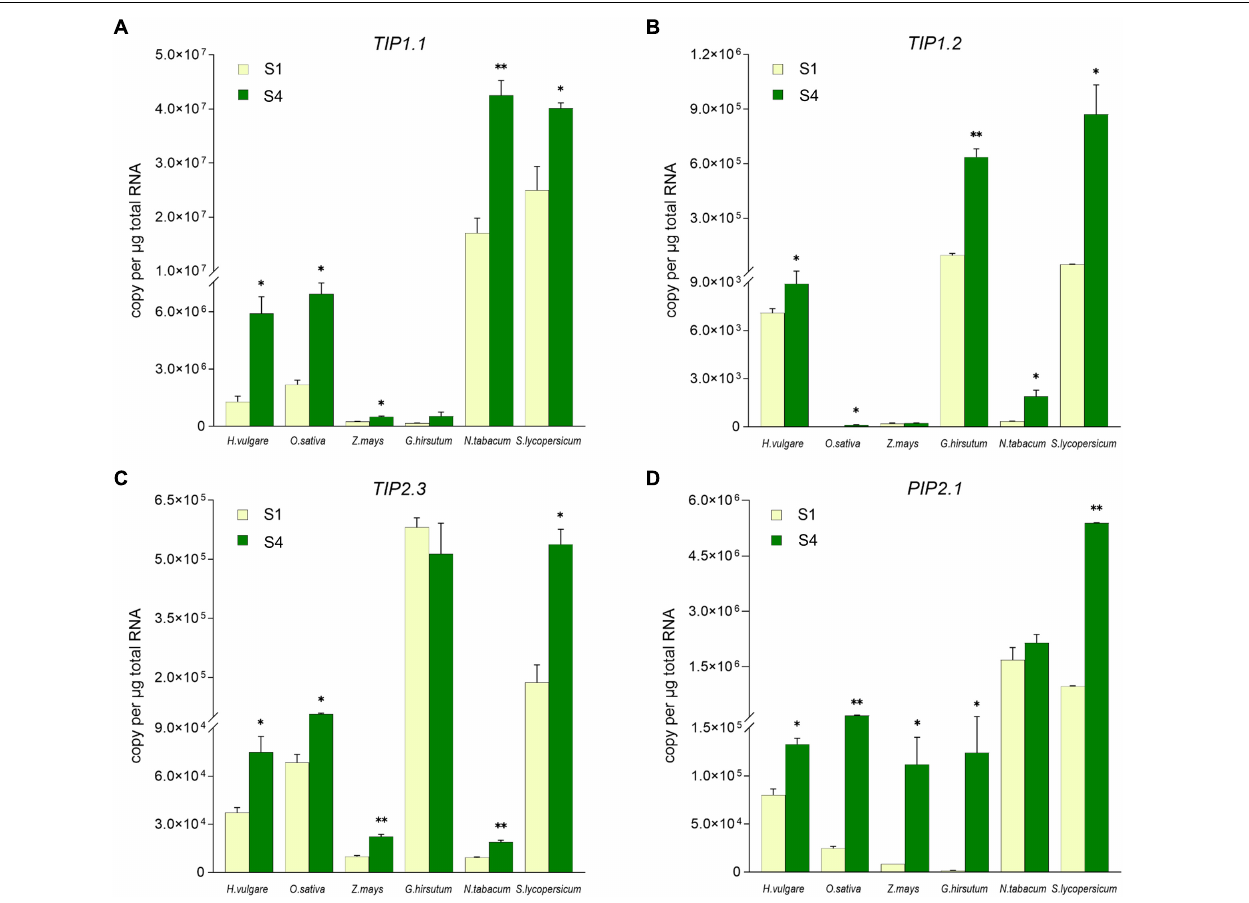
FIGURE 4 | Comparison of the TIP1;1 , TIP1;2 , TIP2;3 , and PIP2;1 expression level in lodicules or petals in six species by absolute quantitative real-time PCR. The expression level of TIP1;1 (A) , TIP1;2 (B) , TIP2;3 (C) , and PIP2;1 (D) in lodicules or petals was compared in Gossypium hirsutum, Oryza sativa , Zea mays , Nicotiana tabacum , Solanum lycopersicum , and Hordeum vulgare . Data are means ± SD ( n = 3). ∗ p < 0.05 and ∗∗ p < 0.01 using Student’s t